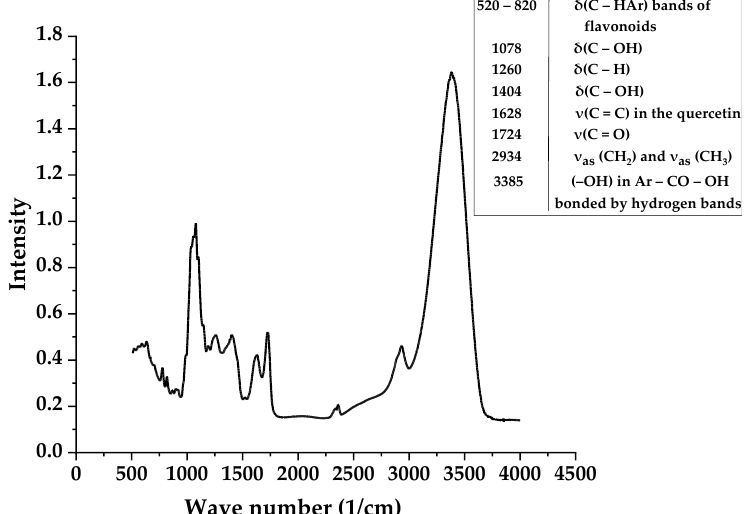
Figure 1. The IR spectrum and interpretation of the peaks of the water–Eth Viburnum opulus L. extract in the KBr pellet.